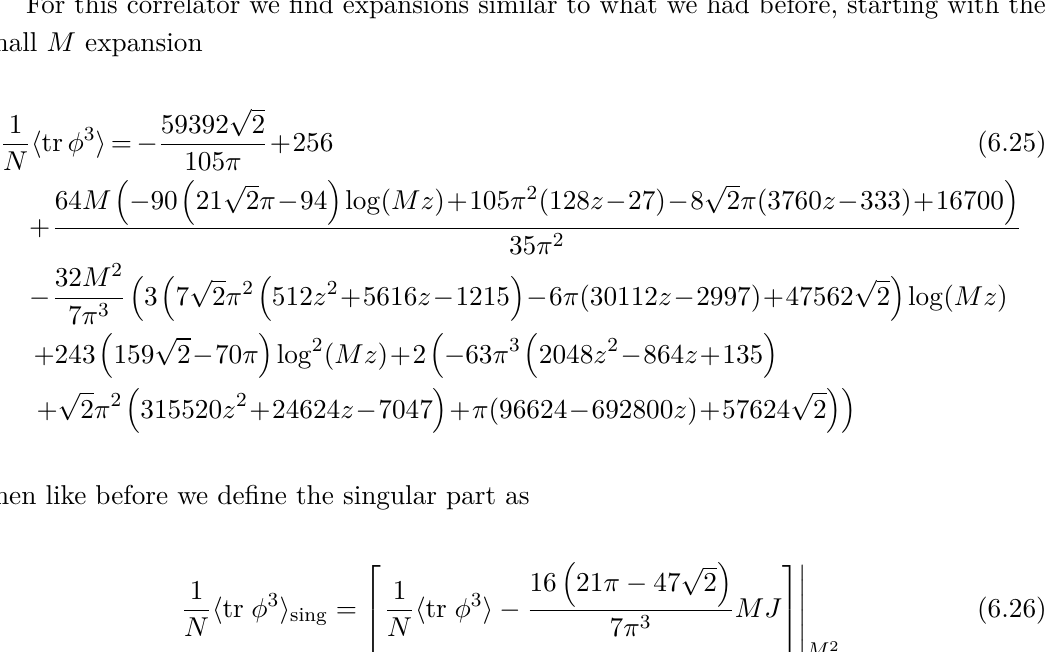
Figure 7 . Plot of the 1-pt function 1 bounded by the critical line. We show the critical line in red, in the planes 1 1 h tr φ 3 i = 0 N